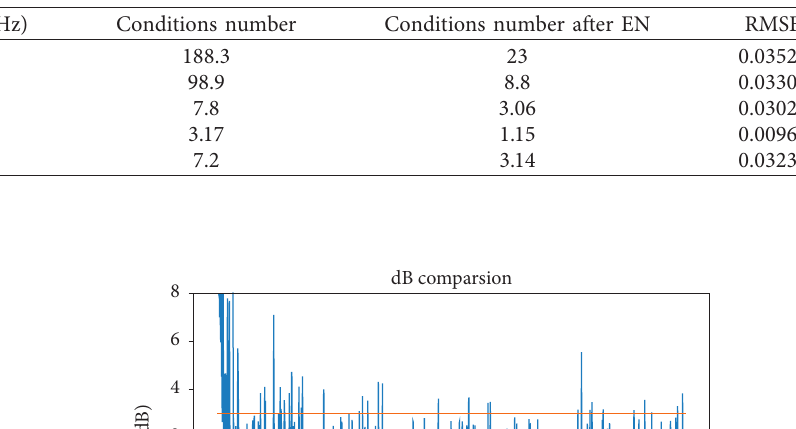
Table 5: Preregularization and postregularization comparisons.